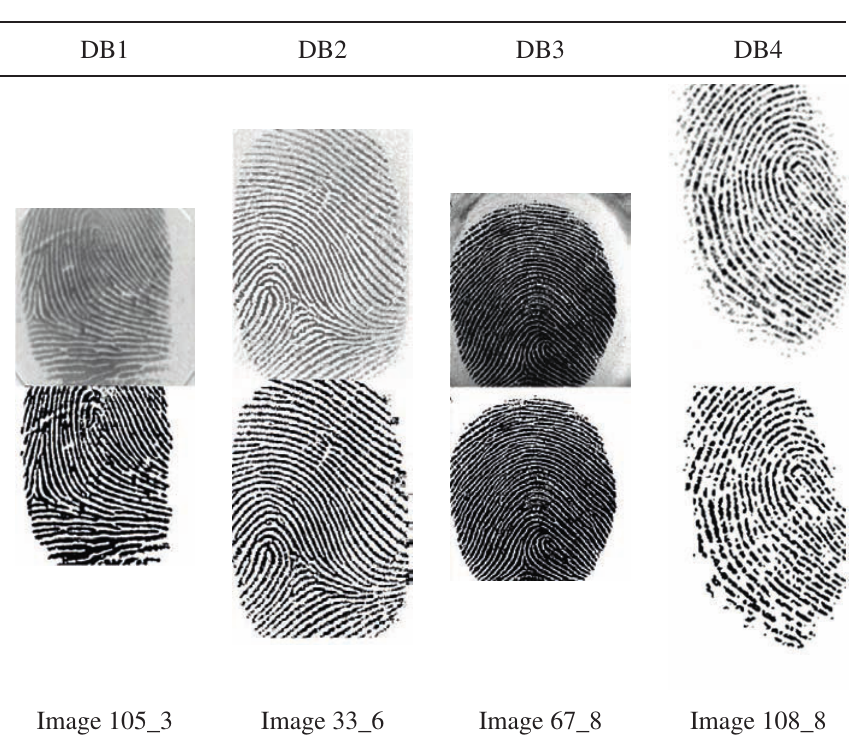
Table 4. Fingerprint images from FVC2000 database segmented by the proposed